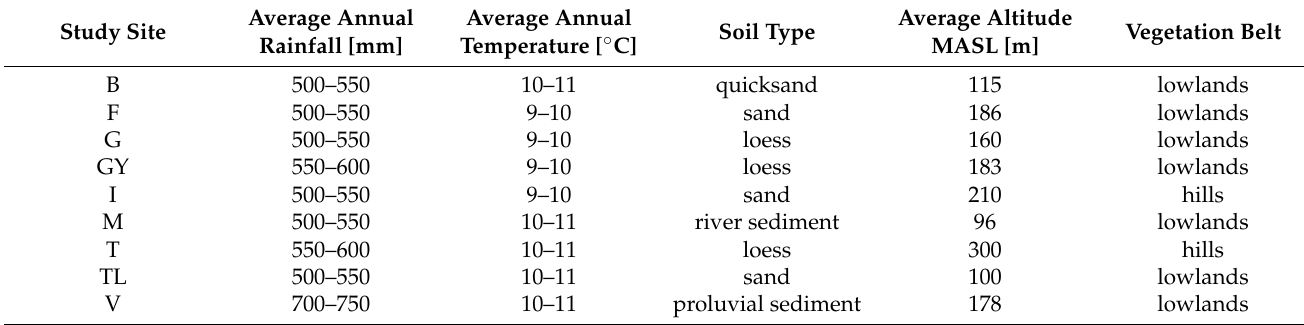
Table 1. Basic data of the study sites (sources